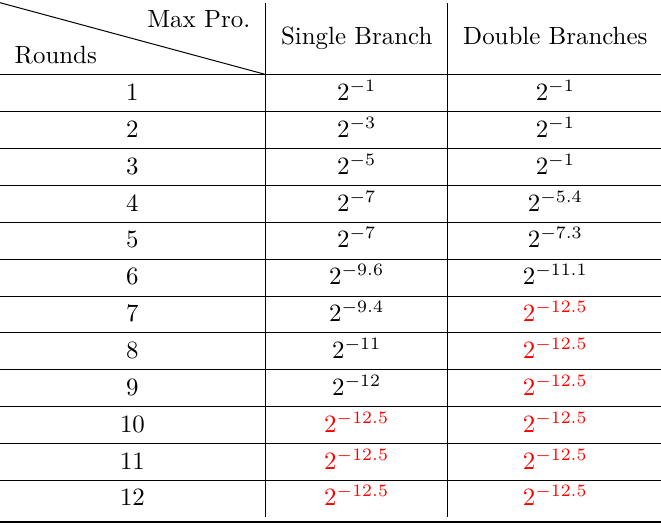
Table 12: The maximal differential probability for each GFS-based construction. Max Rounds